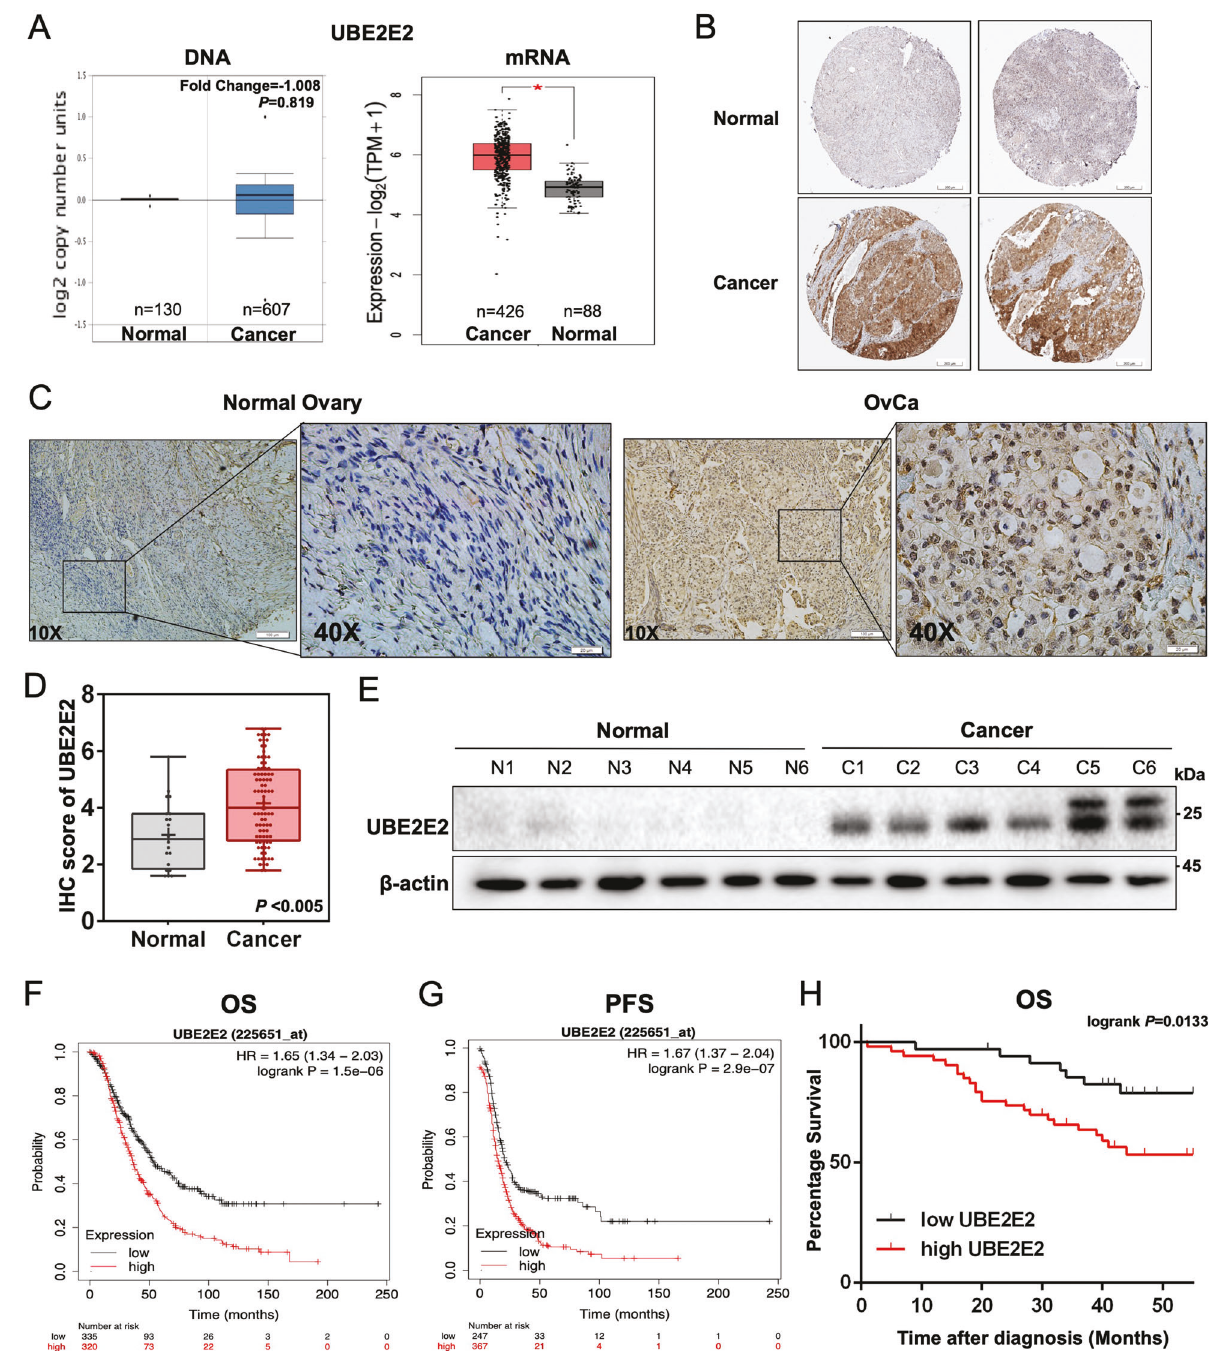
Fig. 1 UBE2E2 is upregulated and associated with poor prognosis in OvCa. A , B The gene expression pro fi le data were obtained from the GEPIA (http://gepia2.cancer-pku.cn/), Oncomine (https://www.oncomine.org/) and The Human Protein Atlas (https://www.proteinatlas.org/) (antibody: HPA028872) online databases. C Representative images of the immunostained UBE2E2 in two patient samples (×10 magni fi cation, scale bar = 100 μ m; ×40 magni fi cation, scale bar = 20 μ m) are shown. D The protein level of UBE2E2 was signi fi cantly increased in OvCa tissues (normal ovarian tissue, n = 20; OvCa tissue, n = 88). E Western blot analysis was performed to determine the expression levels of UBE2E2 in OvCa and normal ovarian tissue samples ( n = 6); β -actin served as the loading control. F , G Overall survival (OS) and progression-free survival (PFS) analyses were performed with Kaplan – Meier plotter (http://www.kmplot.com) (Affymetrix ID: 225651_at). H Kaplan – Meier survival analysis was conducted by log-rank test ( n = 88). the interaction between these factors, Flag-tagged UBE2E2 and We then veri fi ed the role of p62 in regulating the expression of p62 vectors were transfected into cells, and co-IP assays were Snail in OvCa cells. As shown in Fig. 4D, p62 overexpression performed. We did not observe any direct interactions between increased the protein level of Snail and the repression of UBE2E2 and p62 or Snail (Fig. 4E), or physical interaction between E-cadherin expression in SKOV3 and A2780 cells. To investigate Cell Death and Disease (2023)